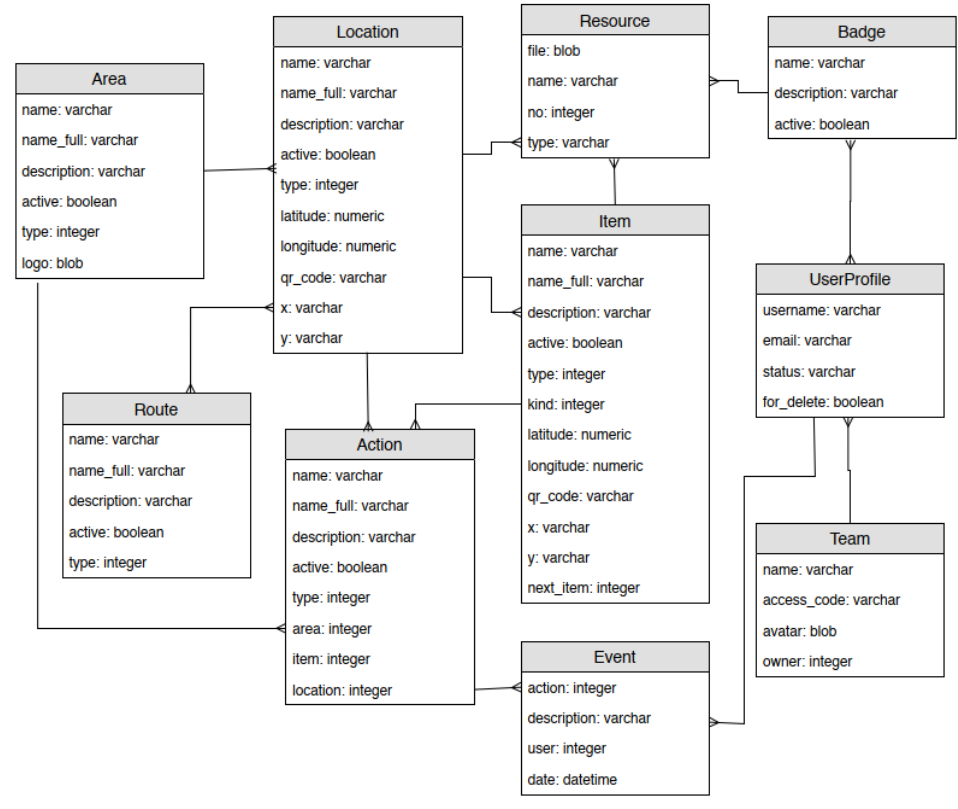
Figure 1. A simplification of the data model referenced by the API.